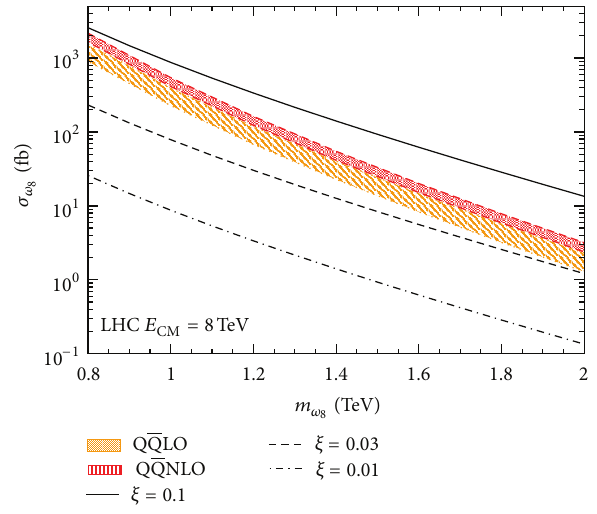
Figure 5: Production cross-section of 𝜔 8 at the LHC running at 7 TeV (a) and 14TeV (b) for various 𝜉 = 𝑓 𝜔 cross-sections at LO and NLO are also plotted for comparison.